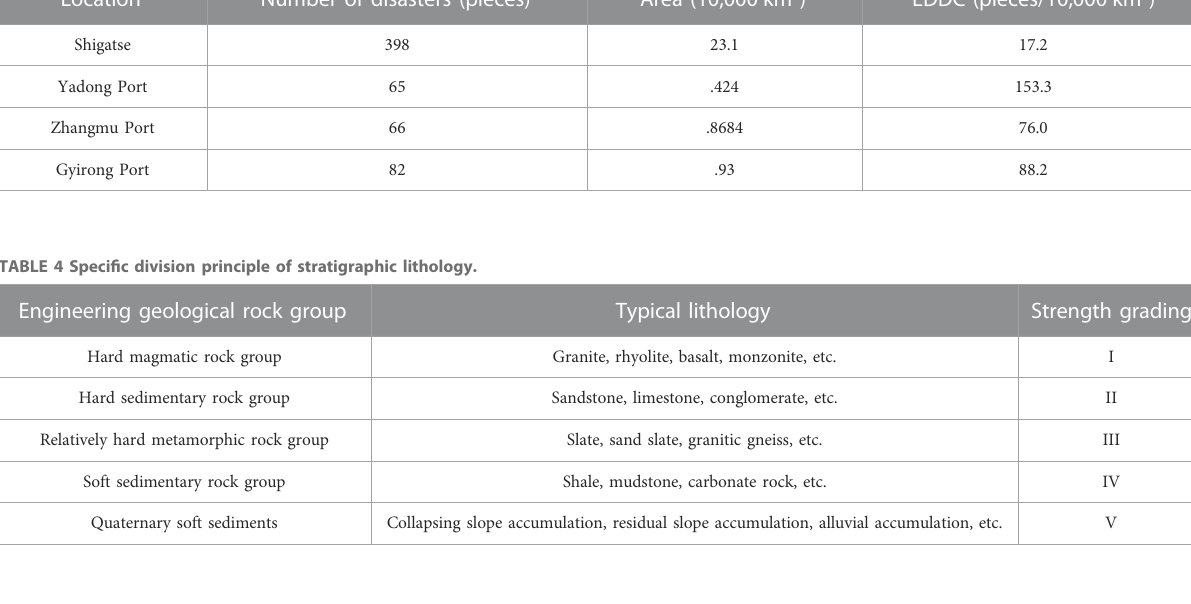
TABLE 3 EDDC in Shigatse City and three major ports. Location